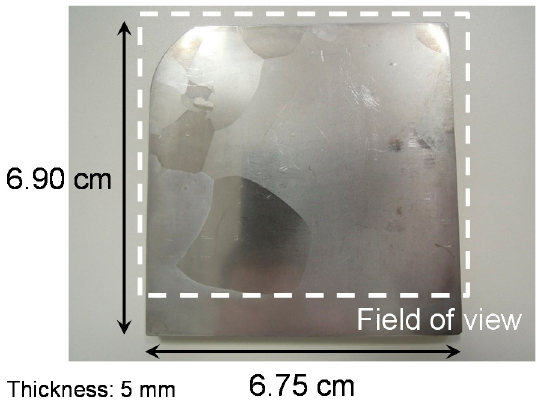
Figure 19. Photograph of the Si-steel plate sample for demonstration of grain orientation imaging using Bragg-dip neutron transmission method [28].